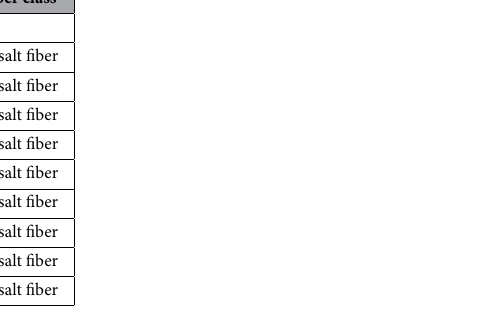
Table 3. Parameters of direct shear